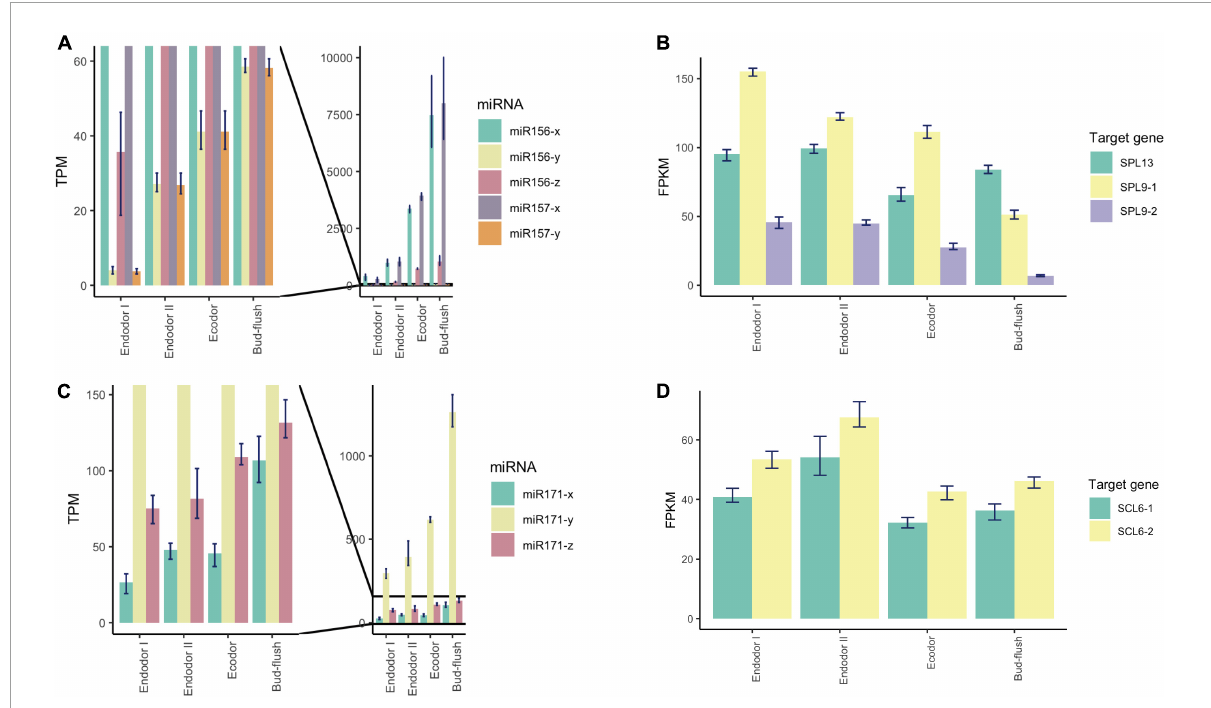
FIGURE6 Expression pattern analysis of miR156, miR157, miR171, and their target genes during floral bud break in P. mume . (A,B) The barplots revealing the expression levels of miR156/157-x/y/z (A) and their target genes (B) during floral bud break process. (C,D) The barplots revealing the expression levels of miR171-x/y/z (C) and their target genes (D) during floral bud